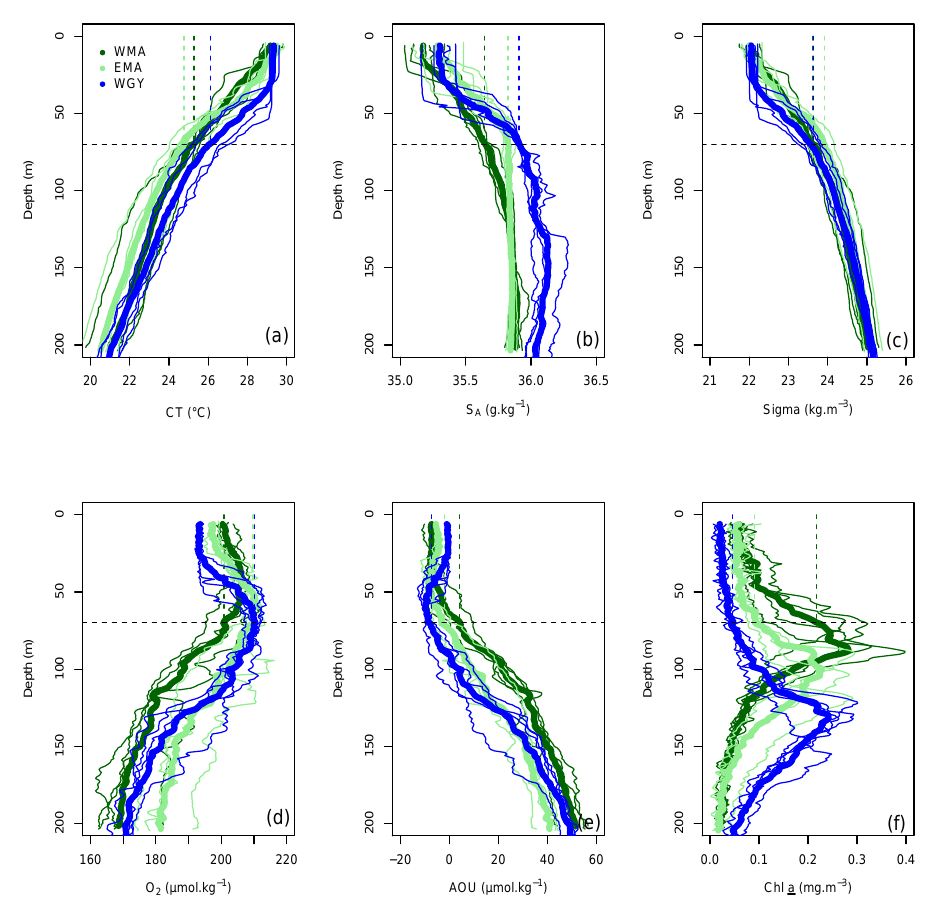
Figure 3. Vertical profiles of (a) conservative temperature (CT in ◦ C), (b) absolute salinity ( S A in gkg − 1 ) , (c) potential density (Sigma in kgm − 3 ) , (d) dissolved oxygen (O 2 in µmolkg − 1 ) , (e) apparent oxygen utilization (AOU in µmolkg − 1 ), and (f) Chl a (mgm − 3 ) versus depth (0–200m) in the three distinct areas sampled during the OUTPACE cruise: the western Melanesian Archipelago (WMA in dark green), the eastern Melanesian Archipelago (EMA in light green), and the western SP gyre (WGY in blue). The horizontal dashed lines indicate the mixed layer depth of 70m. The vertical dashed lines indicate the upper surface expected values for all variables during the 2014 austral